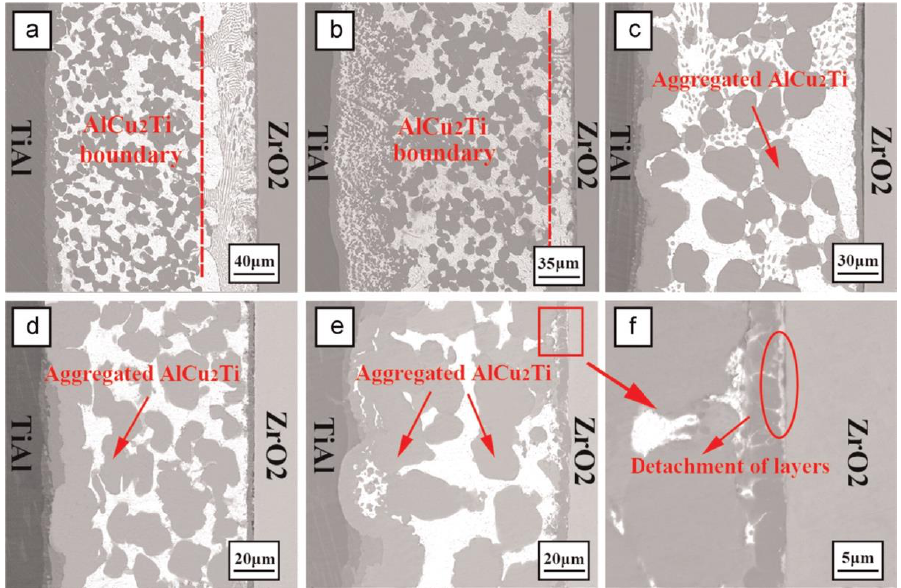
Figure 6. Microstructures of TiAl/ZrO 2 joint produced at: ( a ) 860 °C; ( b ) 880 °C; ( c ) 900 °C; ( d ) 920 °C; ( e ) 940 °C and ( f ) high magnification of reaction layer adjacent to ZrO 2 , reproduced from Reference [27] with permission of Elsevier, 2015.